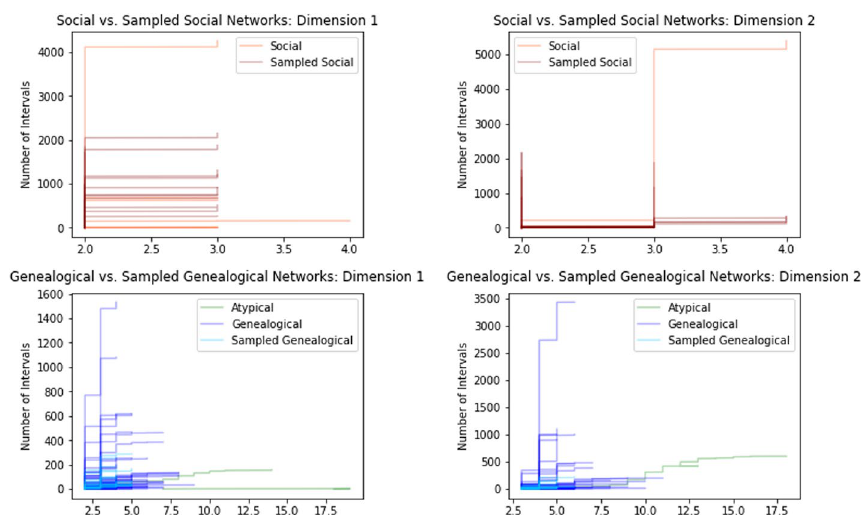
Fig. 9 Comparison of persistence curves for full networks vs sampled networks, grouped by dimension and type of network. Upper Row: Sampling social networks typically stretches the persistence curve in only one axis without affecting the other axis. Lower Row: Sampling genealogical networks typically shrink the persistence curve in both axes. Overall the average slope for social networks tends to increase when sampled, while genealogical networks experience a decrease in average